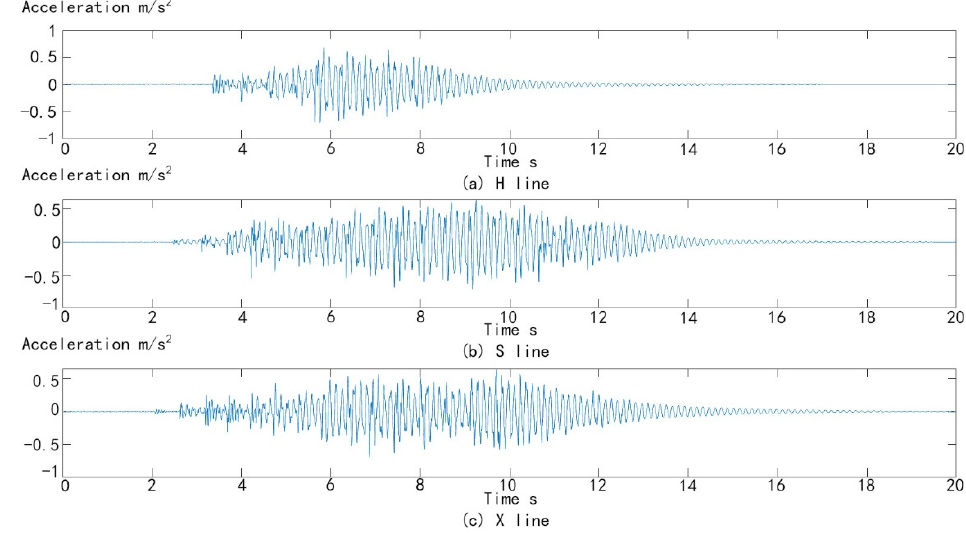
Figure 19. Acceleration response of T3 floor.